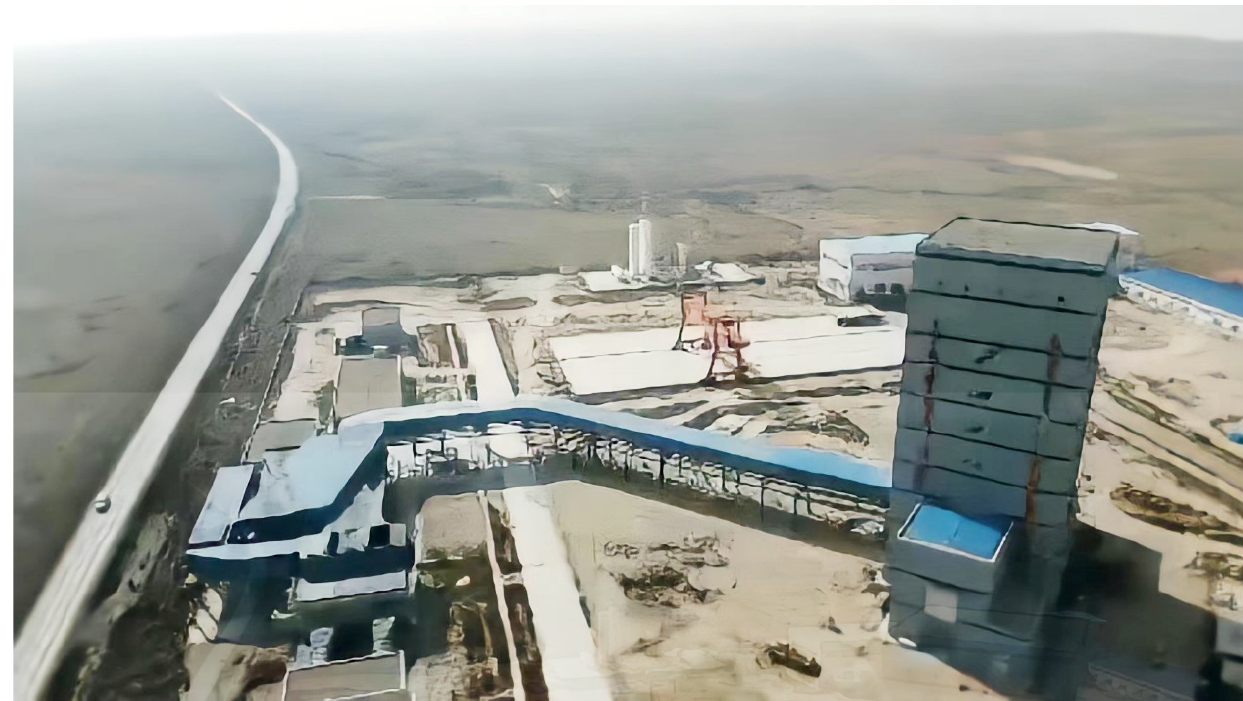
Figure 7. Engineering drawing of gravity heat pipe heat exchange project in a mine. Figure 8 shows the heat transfer of gravity heat pipes in different tube rows. By analyzing the heat exchange process of each row of heat pipes, the change rules of the fresh air temperature, water film temperature, and heat transfer and heat transfer resistance passing through each row of heat pipes can be obtained clearly.